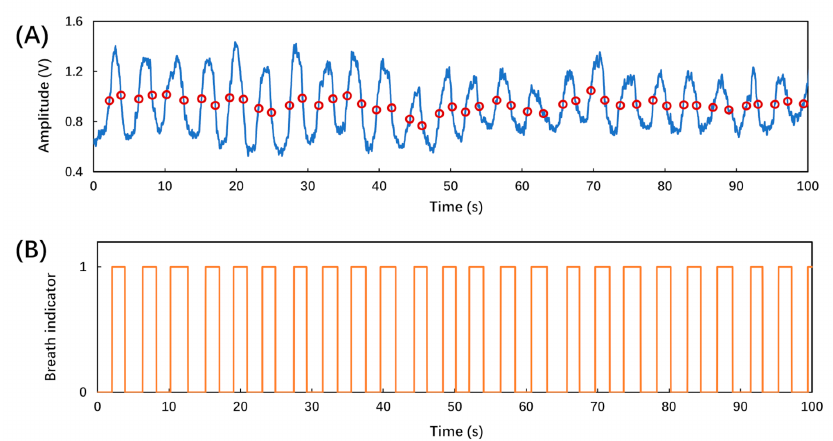
Figure 7. ( A ) Experimentally recorded breathing pattern using the breath sensor, in which the blue curve represents the time-dependent amplitude of the reflected light, and the empty red circles represent the dynamic thresholds in real time; ( B ) output of the breath analysis program using the dynamic thresholds corresponding to a regular breathing pattern.